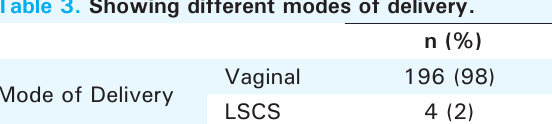
Table 3. Showing different modes of delivery.